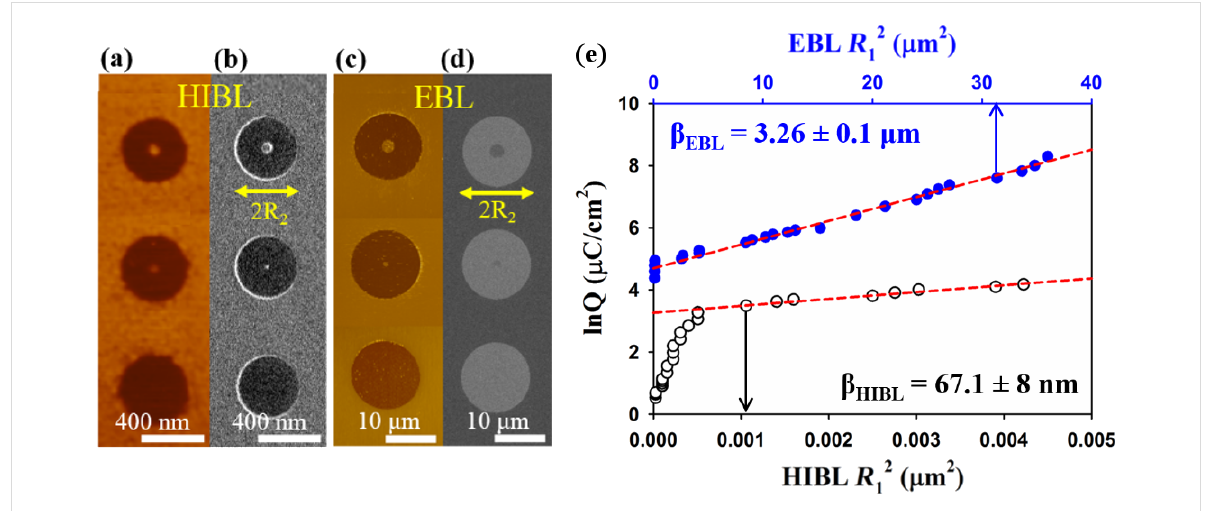
Figure 8: (a) AFM and (b) corresponding HIM, (c) AFM and (d) corresponding SEM images of doughnuts fabricated using SHIBL and EBL with fixed outer radii ( R 2 ) of 200 nm and 7 μ m, respectively, and varied inner radii ( R 1 ). (e) Comparison of the proximity effect for SHIBL and EBL on 20 nm thick PMMA